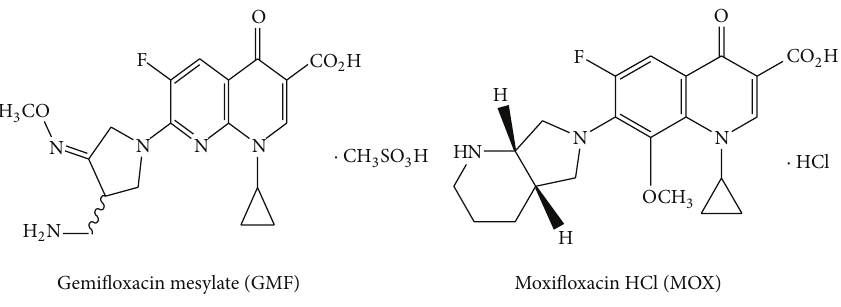
Scheme 1: The chemical structure of the studied drugs.